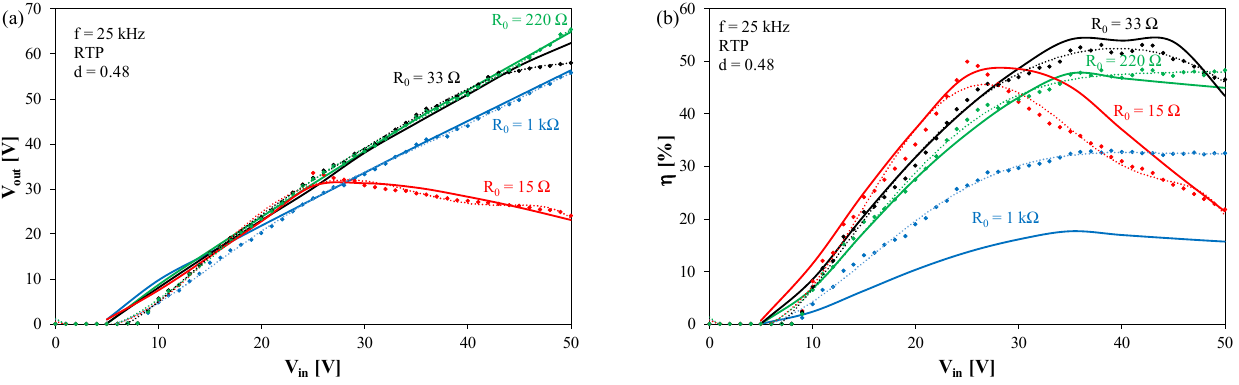
Figure 11. Measured and computed simulated with the proposed model of the transformer dependences of the output voltage ( a ) and energy efficiency ( b ) of the tested DC-DC converter on its input voltage at f = 25 kHz.